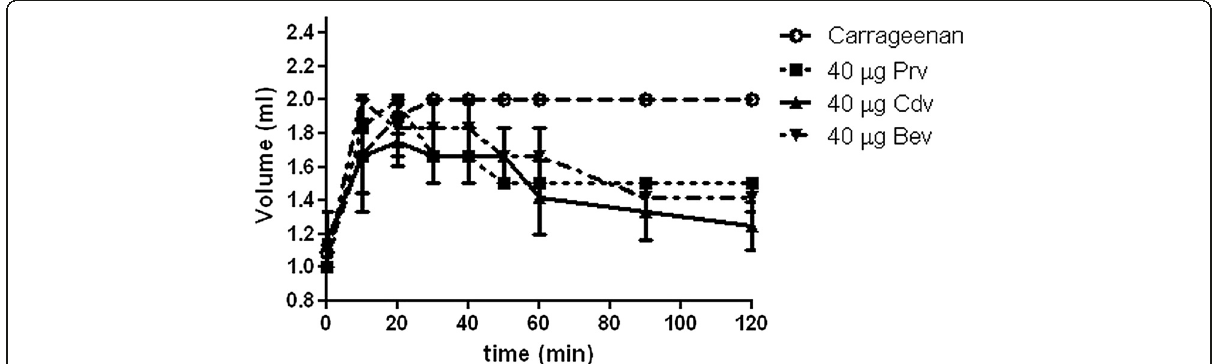
Fig. 3 Volume of rat paw edema induced by subplantar injection of 40 μ g of P. regalis ( Prv ), C. darlingi ( Cdv ), and B. epicureanum ( Bev ) venom protein. The positive control group received 100 μ L of 1 % carrageenan solution, while the negative control group received 50 μ L of saline solution (this did not induce detectable volume changes). Values represent the mean±standard error ( n =3)